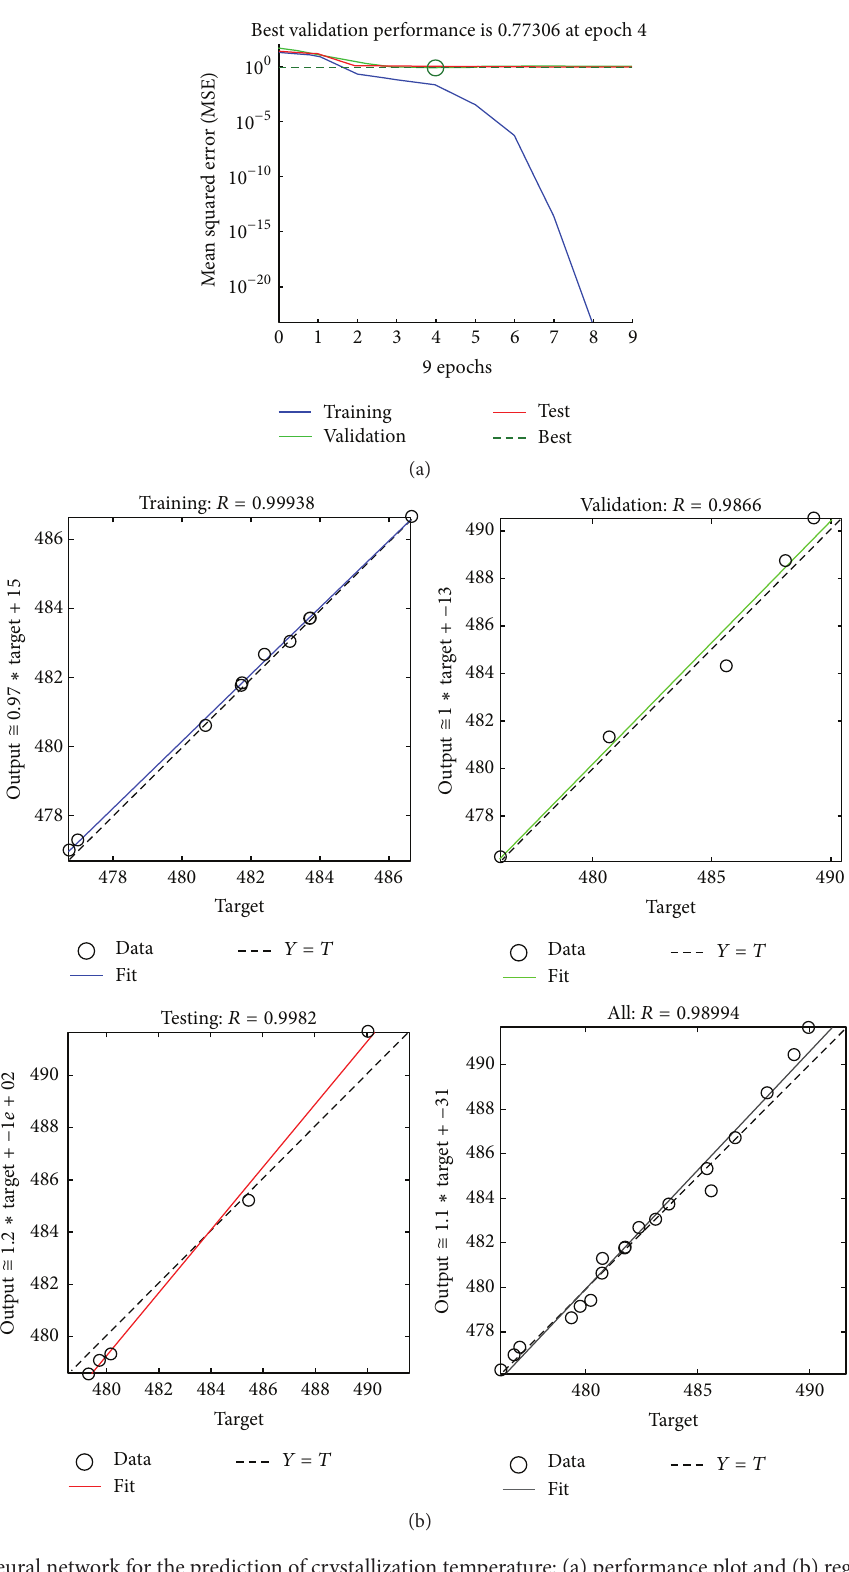
Figure 7: Neural network for the prediction of crystallization temperature: (a) performance plot and (b) regression